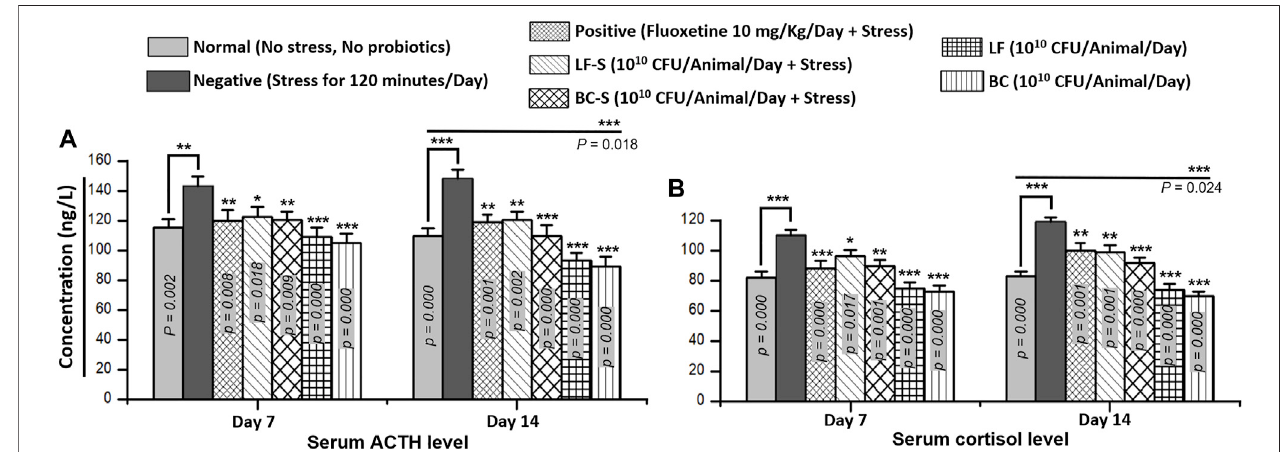
FIGURE2| Effects of Lactobacillusfermentum NMCC-14 (10 10 CFU/day,p.o)and Bacillusclausii (10 10 CFU/day,p.o)onserum (A) adrenocorticotropichormone (ACTH) and (B) cortisol levels. Compared to the negative group, Lactobacillus fermentum NMCC-14 (10 10 CFU/day, p.o) and Bacillus clausii (10 10 CFU/day, p.o) signi fi cantly( n =5/group)reducedtheACTHandcortisollevelsintheLF-SandBC-Sgroups.Comparedtothenormalgroup,BCsigni fi cantlydecreased(day14:ACTH, p =0.018;cortisol, p= 0.024)the ACTH level intheBCgroup animals on day 14and nosigni fi cant( p < 0.05) changein theACTH and cortisol levels wasobserved both in the LF and other BC group animals. Values expressed are mean ± standard error to the mean (SEM). Note that # p = 0.05, * p < 0.05, ** p < 0.01, and *** p < 0.001 versus the negative group by applying two-way